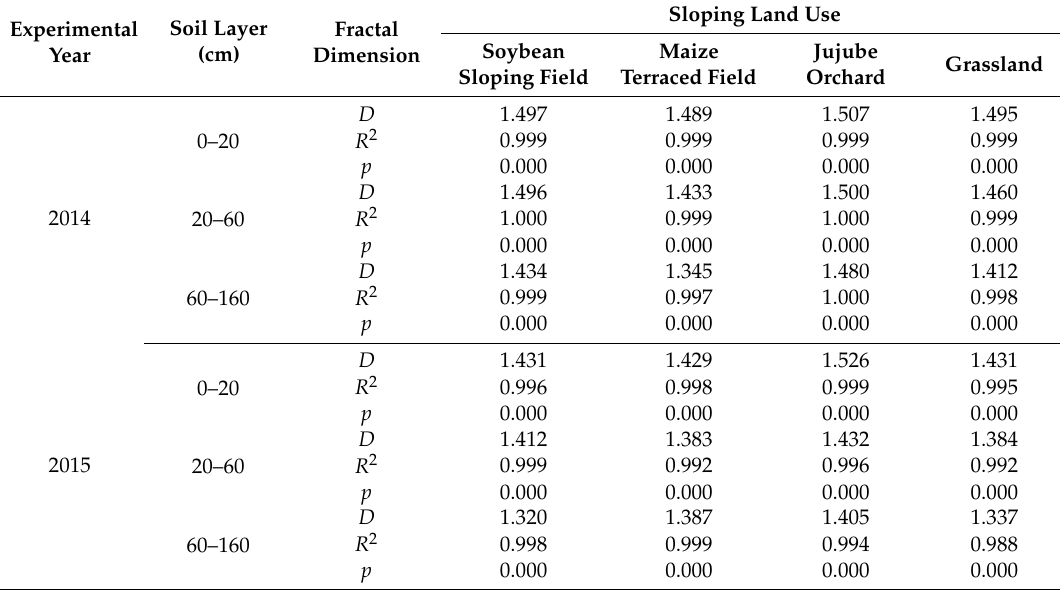
Table 5. Fractal dimension of soil moisture in 0–20 cm, 20–60 cm, and 60–160 cm soil layers under di ff erent sloping land uses during the 2014 and 2015 growing seasons. Experimental